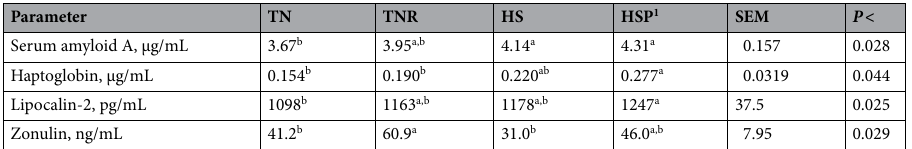
Table 3. Markers of inflammation increased in HS and HSP Holstein bull calves (n = 8 per treatment). TN thermoneutral, TNR thermoneutral feed-restricted, HS heat stress, HSP heat stress-postbiotic, SEM standard error of the mean. a,b Values within the same row with different superscripts denote significance differences ( P < 0.05). 1 AO postbiotic fed at 3 g/calf/day and mixed with milk replacer.